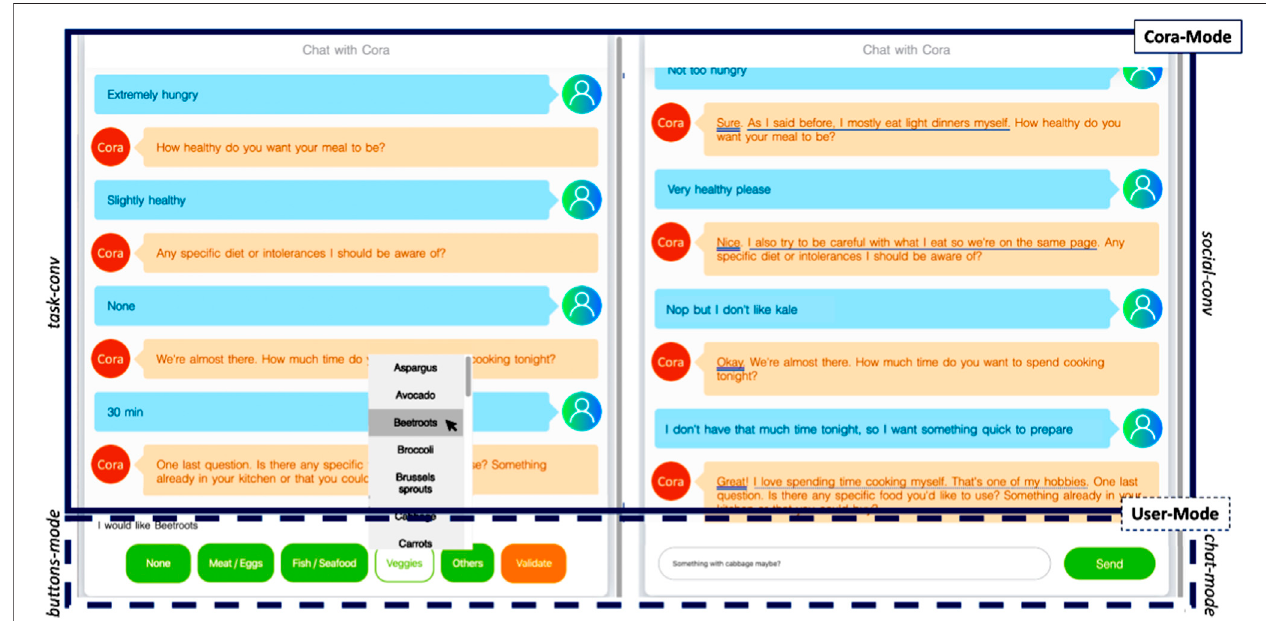
FIGURE 2 | Excerpts of interactions between Cora and its user showing the two Cora-Modes ( task-conv vs social-conv ) and the two User-Modes ( buttons-mode vs chat-mode ) used in our experiment. The rapport-building conversational strategies used by Cora in the social-conv mode are underlined in the dialogue: acknowledgments with a double line, reciprocal appreciations with a single line and self-disclosures with a dotted line.